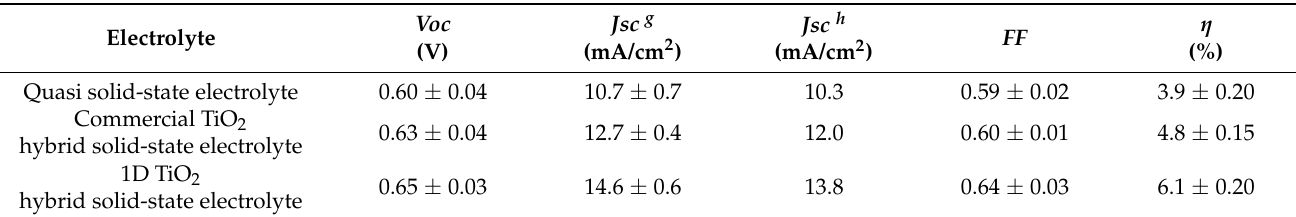
Table 2. Electrochemical parameters of mesoporous carbon-based DSSCs with quasi solid-state electrolyte, commercial TiO 2 hybrid solid-state electrolyte and 1D TiO 2 hybrid solid-state electrolyte, as determined by EIS analysis at 100 mW/cm 2 (AM 1.5). Error bars represent the standard deviation of at least 5 cells. Electrolyte Quasi solid-state electrolyte Commercial TiO 2 Hybrid solid-state electrolyte Hybrid solid-state electrolyte